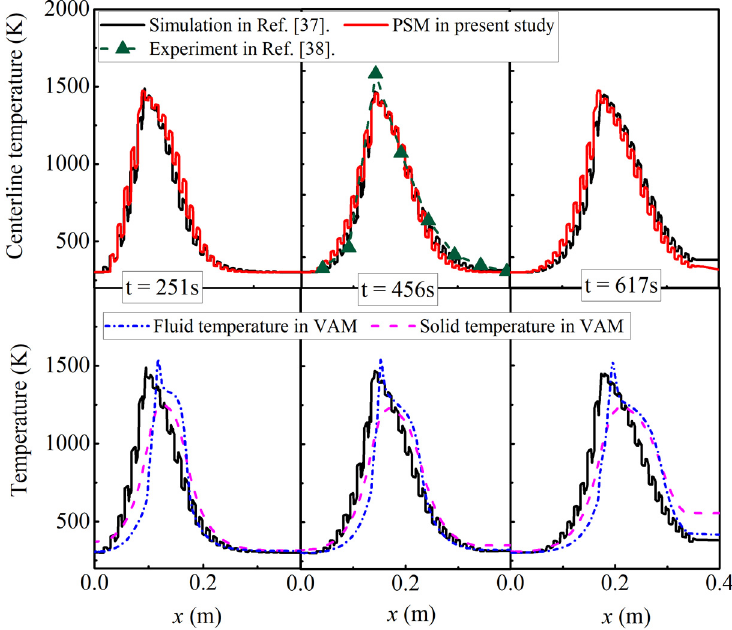
Figure 3. Model validation.